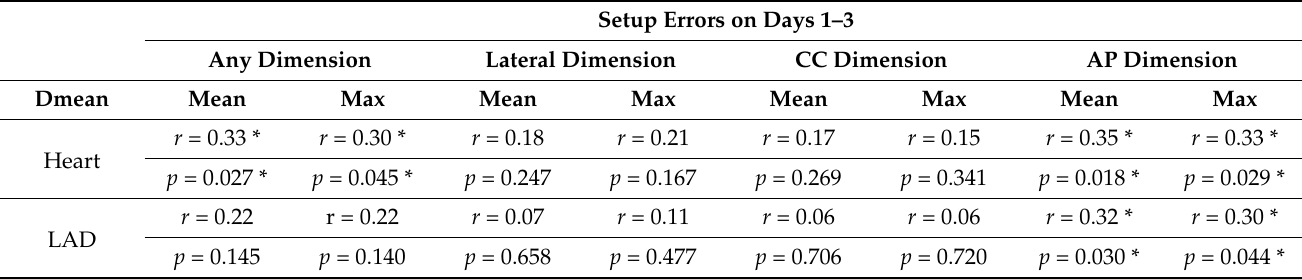
Figure 5. Relation between heart ( a ) and ipsilateral lung ( b ) exposure and (mean and maximum) setup errors in any dimension. *statistically significant ( p < 0.05). Table 2. Correlation analysis for OAR exposure and setup errors on days